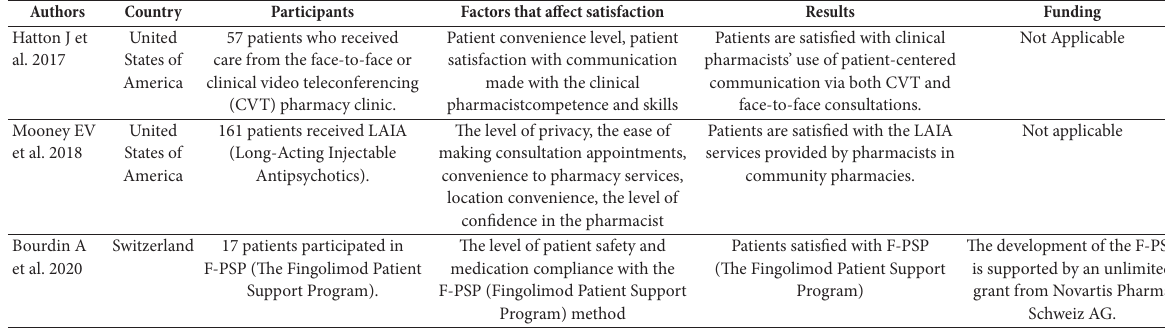
Table 4. Patient satisfaction with patient support program